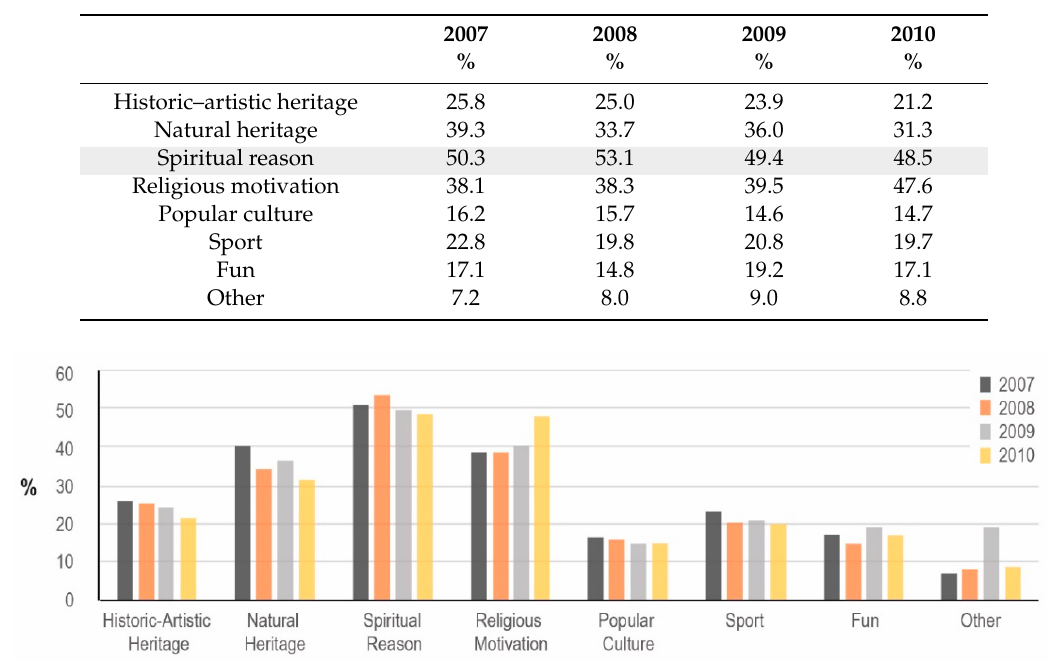
Table 4. Main reasons for doing The Way (Spiritual reasons, highlighted with grey background, are the most cited). Own preparation based on data from Pilgrim Profile Reports, Observatory of The Way. (CETUR and SA Xacobeo 2007–2010).